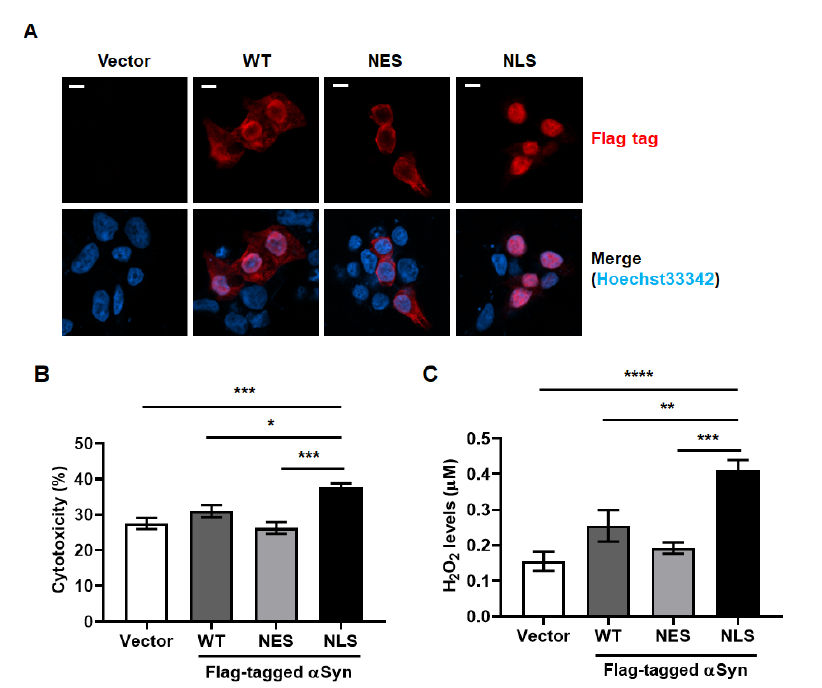
Figure 1. Nuclear localization of α -synuclein ( α Syn) causes oxidative stress-induced cytotoxicity in mouse embryonic fibroblasts (MEF). ( A ) Distinct sub-cellular localization of α Syn was confirmed using immunofluorescent staining; red: Flag tag, Hoechst33342: nucleus. N = 3; white bar: 5 µ m. ( B ) Lactate dehydrogenase (LDH) activity in MEF culture media was measured to represent cytotoxi- city levels derived from the expression of indicated DNA, because the leakage of LDH from damaged cells represents cytotoxicity. Cytotoxicity (%) was calculated with the following: {(the absorbance of LDH activity of sample-the absorbance of negative control with unused normal growth media)/the absorbance of positive control with 1 % triton X-100 in growth media} X 100. WT: the Flag-tagged wild type α Syn, NES: Flag-tagged wild type α Syn conjugated with nuclear export signal, and NLS: Flag-tagged wild type α Syn conjugated with a nuclear localization signal. We used one-way analysis of variance (ANOVA) with Tukey’s post hoc test for statistical analysis. Data are represented as the mean ± SEM. N = 4; * p > 0.05 and *** p > 0.001. ( C ) The levels of hydrogen peroxide (H 2 O 2 ) in MEF cytosol were estimated to analyze the cause of cytotoxicity derived from the distinct sub-cellular localization of α Syn in MEF. We used one-way ANOVA with Tukey’s post hoc test for statistical analysis. Data are represented as the mean ± SEM. N = 4; ** p > 0.01, *** p > 0.001, and **** p >